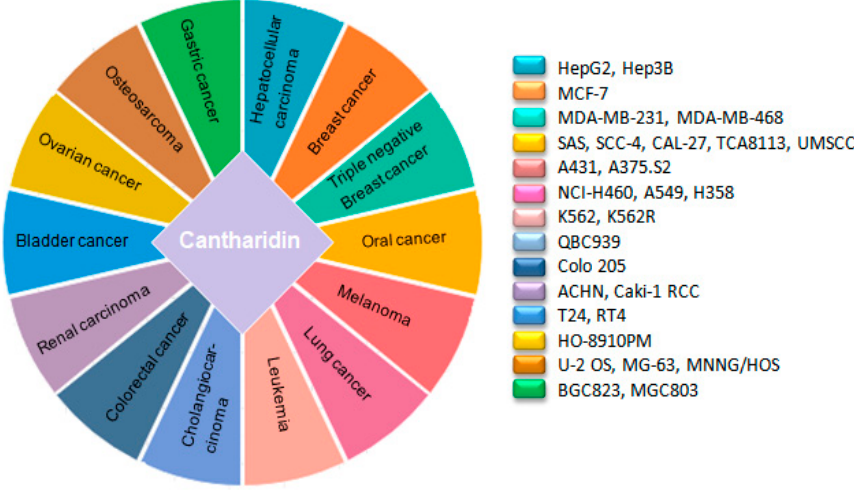
ff erent cancer cell